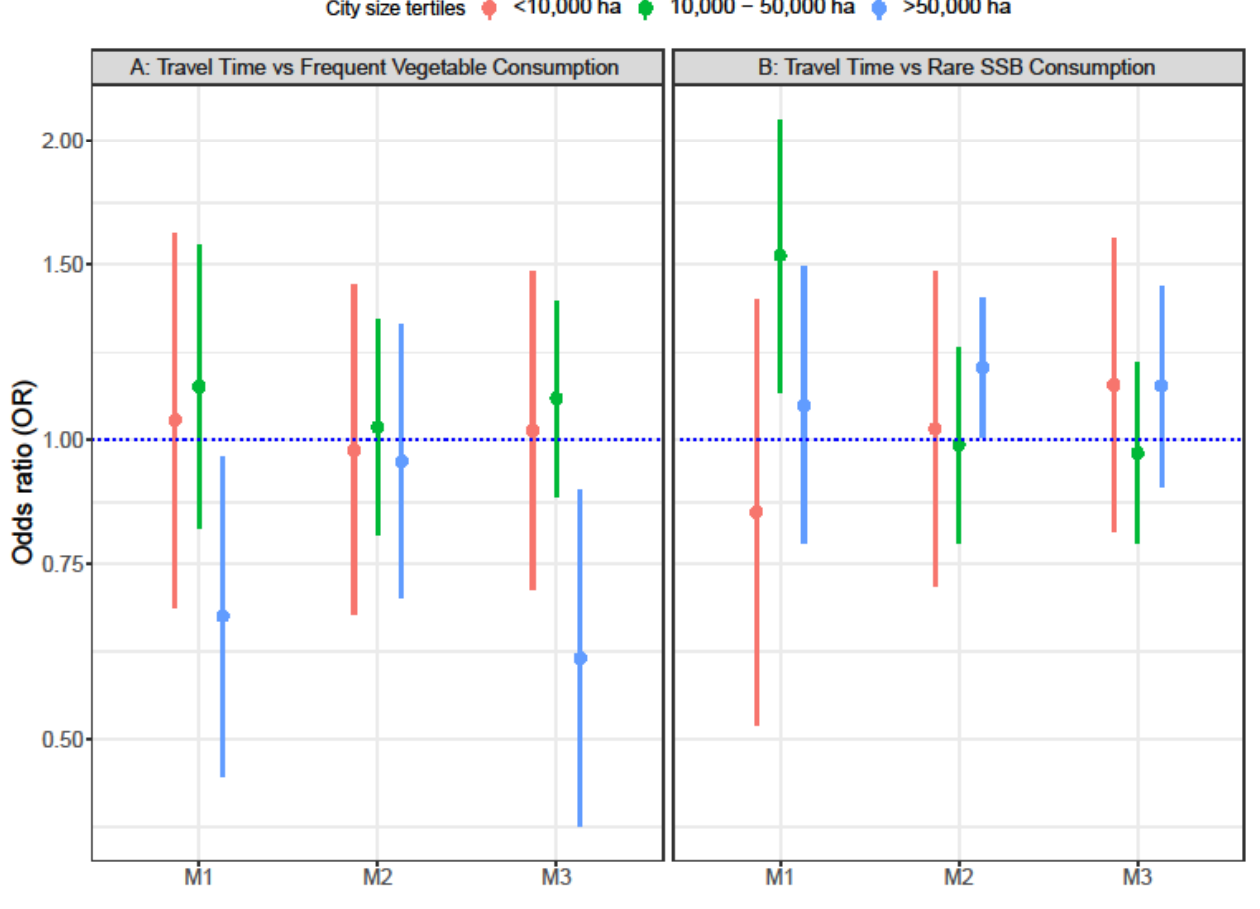
Figure 1. Odds ratios of frequent vegetable consumption (N = 57,170) ( A ) and rare SSB consumption (N = 42,117) ( B ), associated with city level travel time in LA cities, stratified by city size area tertiles. Panel A includes National Health Surveys from Brazil, Colombia, Mexico, Chile, and Peru. Panel B includes National Health Surveys from Brazil, Colombia, and Mexico. M1: + age + sex + education + car ownership. M2: M1 + population density + intersection density + adjusted gas price + presence of mass transportation. M3: M2 + Social environment index.